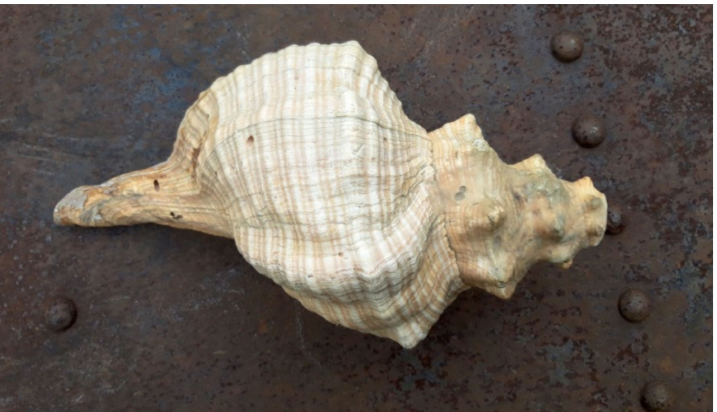
Figure 5. Shell horn made from Triplofusus princeps . Experimental model by the author (2021), length: 35.5